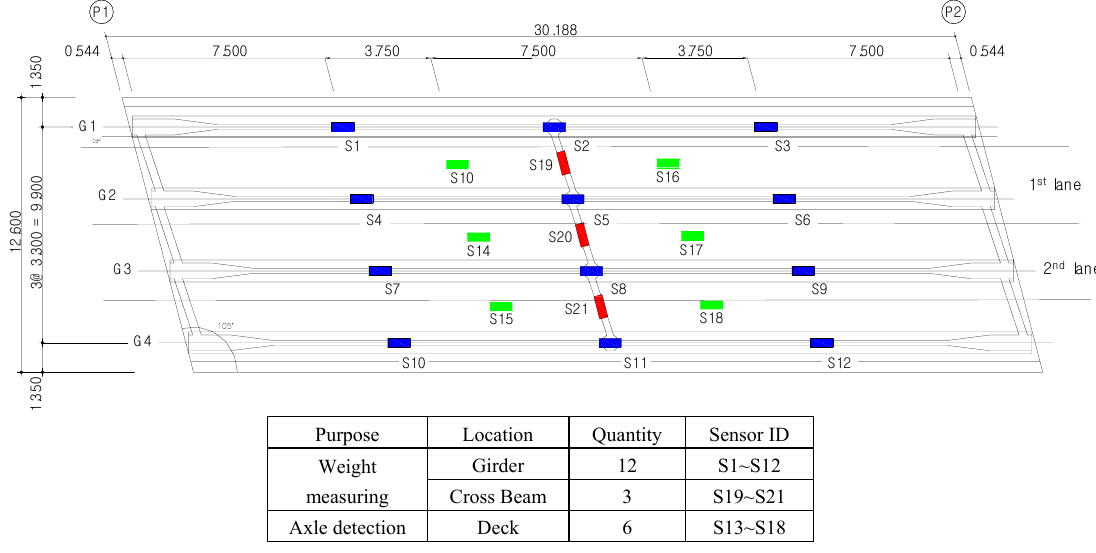
Figure 3. Sensor disposition of Geumdang Bridge (unit: